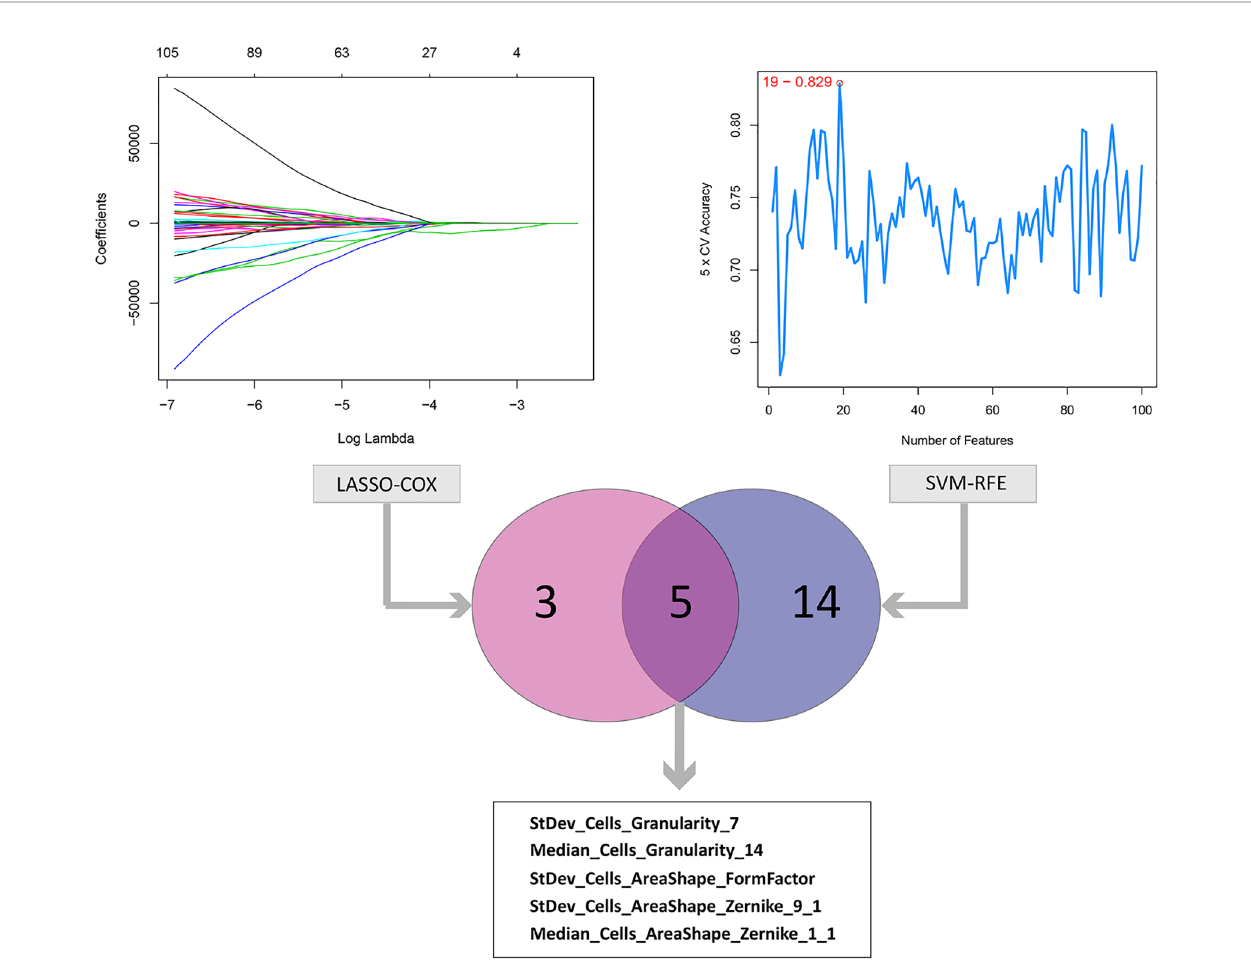
FIGURE 2 | LASSO and SVM-RFE algorithms for the identi fi cation of prognosis-related features. The LASSO-COX regression screened out 8 prognostic features while the SVM-RFE algorithm identi fi ed 19 features at the point highlighted, which indicated the maximal cross-validated accuracy. Taking the intersection of the two result to obtain the 5 prognosis-related